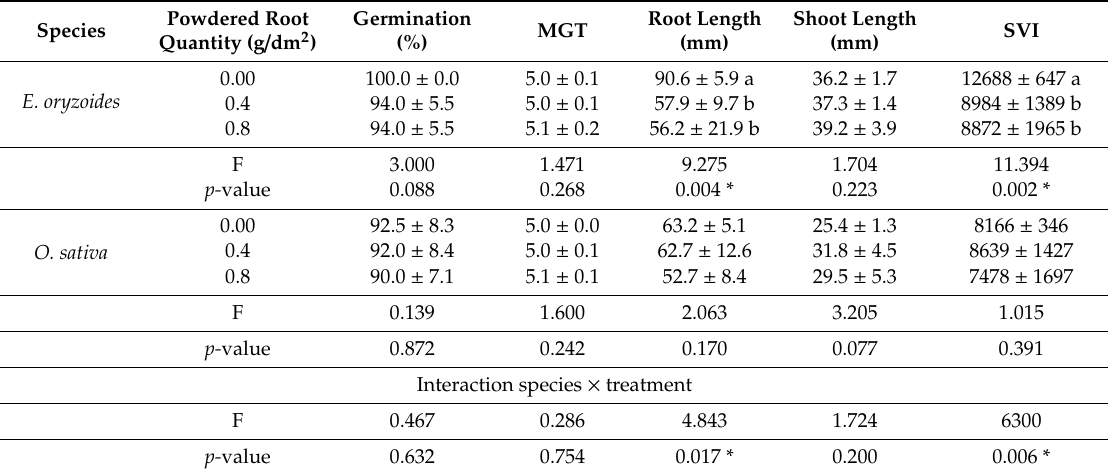
Table 6. Germination indices measured for E. oryzoides and O. sativa under the e ff ect of di ff erent quantity of L. multiflorum powdered roots.